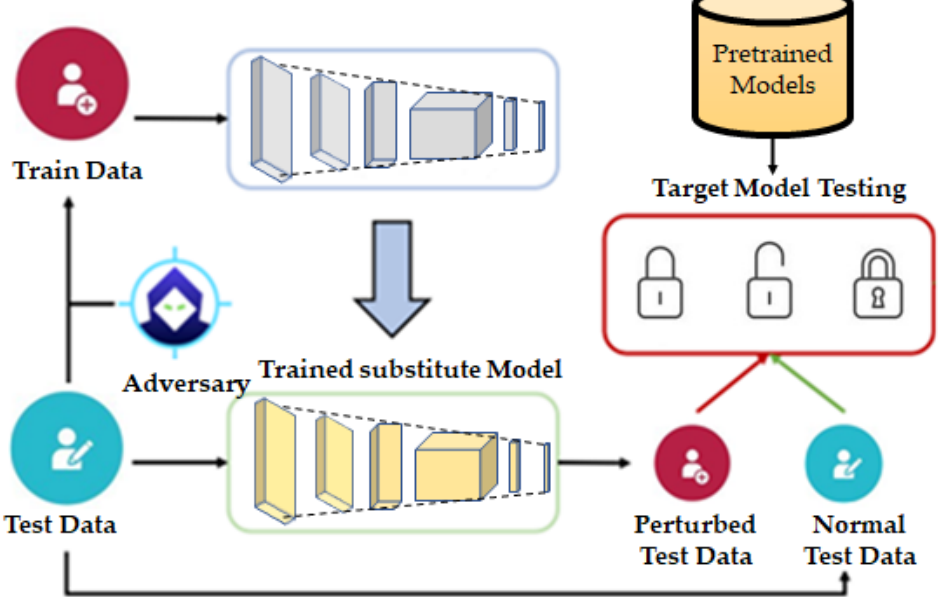
Figure 27. Overview of the HDC model. A deep learning model was trained as a wide deep convolu- tional neural network, and artificial test samples generated by this model were then transferred to target neural network models.